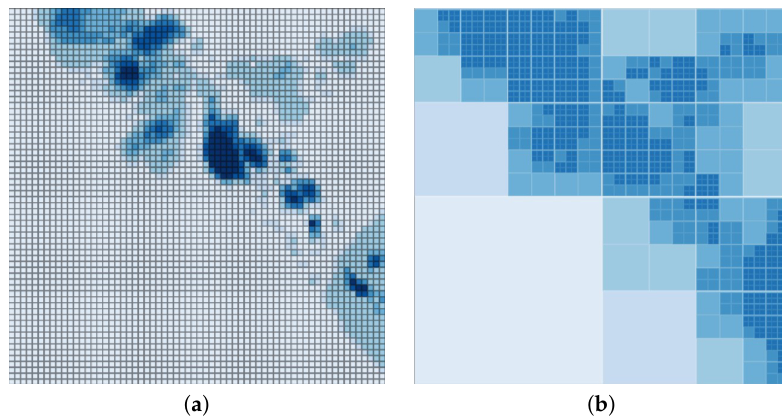
Figure 6. Visualization of the neighborhood flooding using ( a ) regular grids, ( b ) adaptive grids.